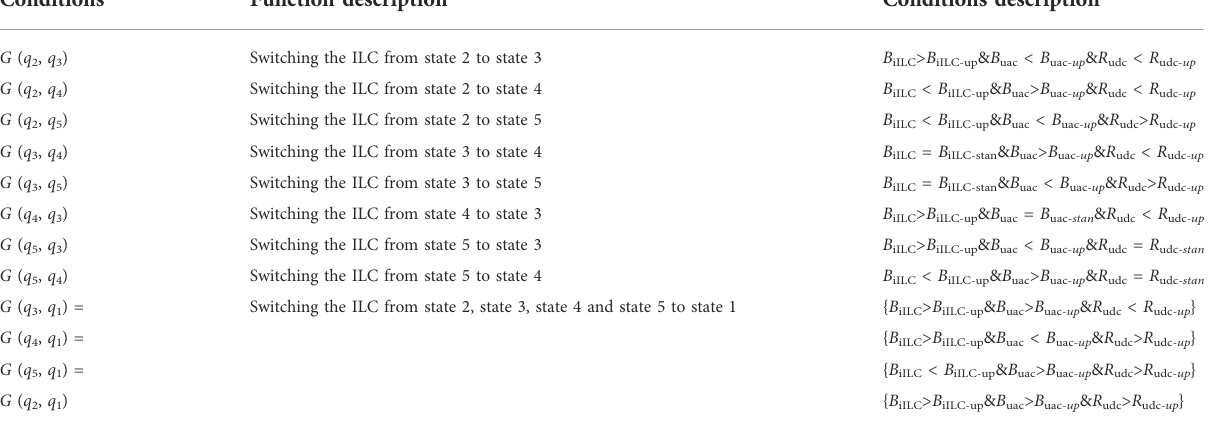
TABLE 1 The conversion conditions of